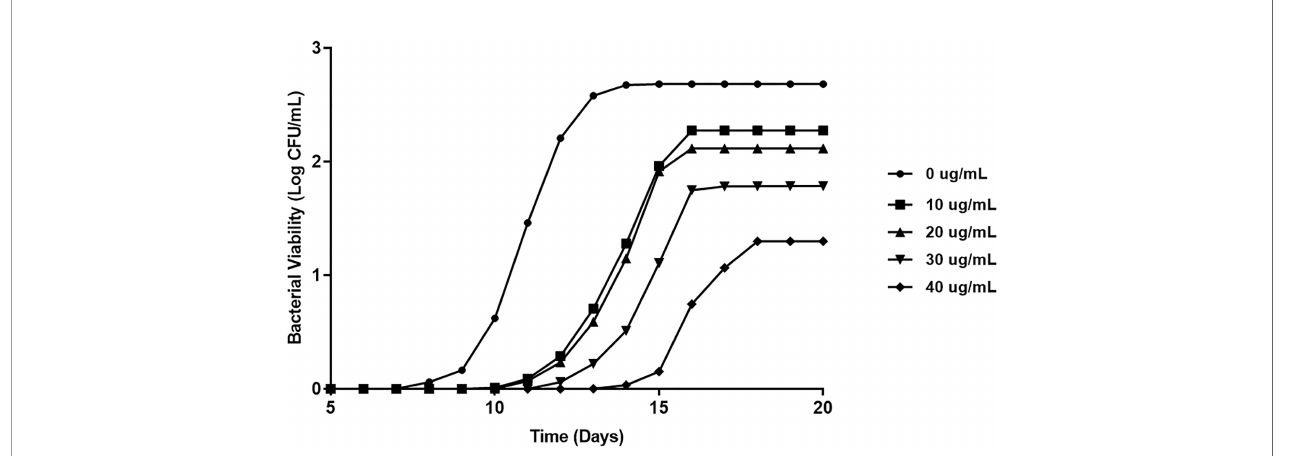
FIGURE 6 | Direct effect of LL-37 treatment on MAP viability in MGIT culture. BD Bactec MGIT ™ Para-TB medium (Becton Dickinson, Sparks, Maryland, USA) system was used to determine the in vitro inhibitory effect of LL-37 on MAP over 20 days. Bacterial viability was calculated using fl uorescence quenching technology and by the BACTEC ™ MGIT ™ 320.